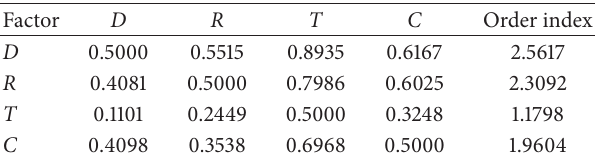
Table 7: Pairwise comparison matrix of 𝑈 2 based on 0.1–0.9